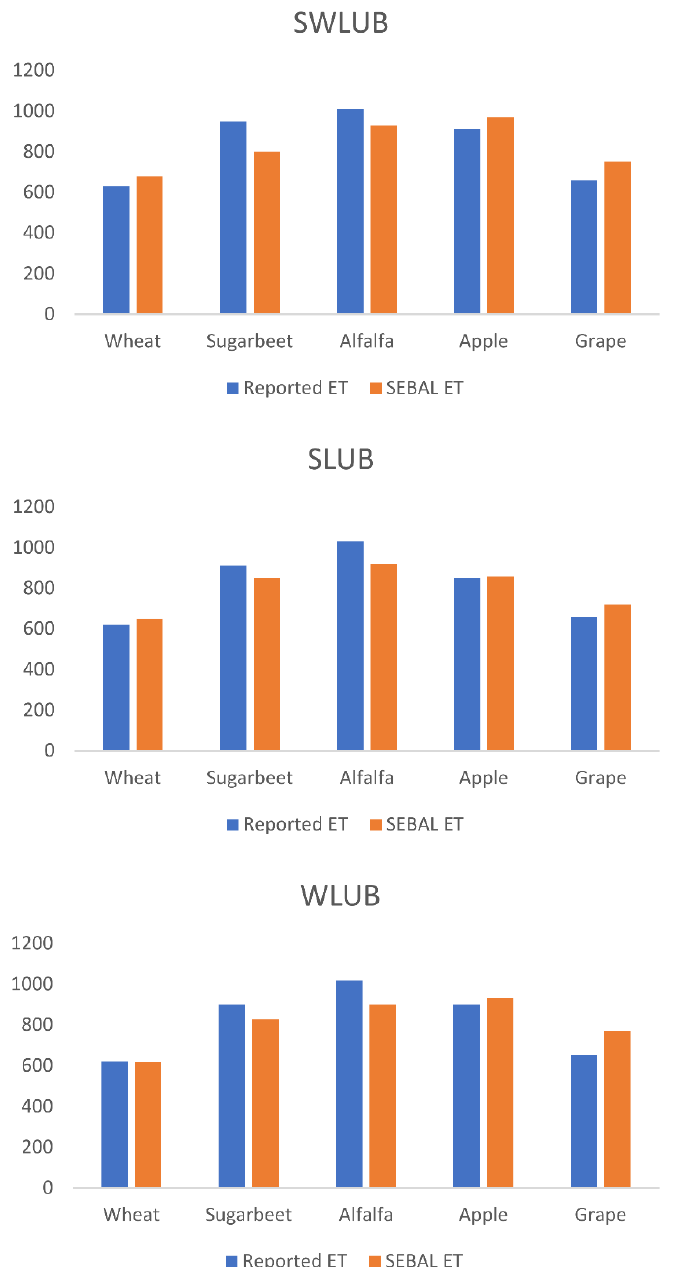
Figure 4. Comparison of SEBAL-based ET and reported water requirement for the selected crops in the study area.